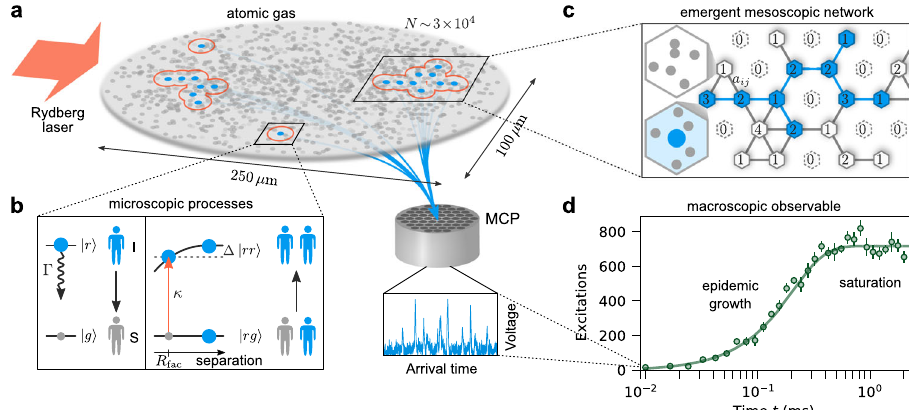
Fig. 1 Physical system for studying epidemic growth and dynamics on complex networks. a Experiments are performed on a two-dimensional gas containing N ~ 3 × 10 4 potassium atoms driven by an off-resonant laser fi eld. The gas is initially prepared with a small number of seed excitations (blue disks), which then evolves according to the microscopic processes depicted in sub- fi gure b, giving rise to growing excitation clusters that spread throughout the system. After different exposure times t , the Rydberg atoms are fi eld ionized and detected on a microchannel plate detector (MCP), where the incident ions create voltage spikes (blue trace). b Each atom can be treated as a two-level system with a ground state g j i (gray disks) and excited Rydberg state r j i (larger blue disks). Excited atoms can decay with rate Γ or facilitate additional excitations with rate κ at a characteristic distance R fac (determined by the laser detuning Δ ) analogous to the transmission of an infection. c The dynamics of this system can be described by a susceptible- infected-susceptible (SIS) model on an emergent heterogeneous network. Each node i represents a discrete cell of the coarse-grained system, which can be infected (with excitation, blue) or susceptible (without excitation, white) and is connected to neighboring nodes according to the adjacency matrix a ij . The infection probability of each node is weighted by the number of atoms in that cell that can undergo facilitated excitation N i (indicated by the numerical labels on each node). Disconnected nodes with N i = 0, corresponding to vacant cells, are depicted with dashed lines. d Exemplary data and numerical simulations (solid line) showing two different stages of dynamics: rapid growth followed by saturation. Error bars represent the standard error of the mean over typically 16 experiment